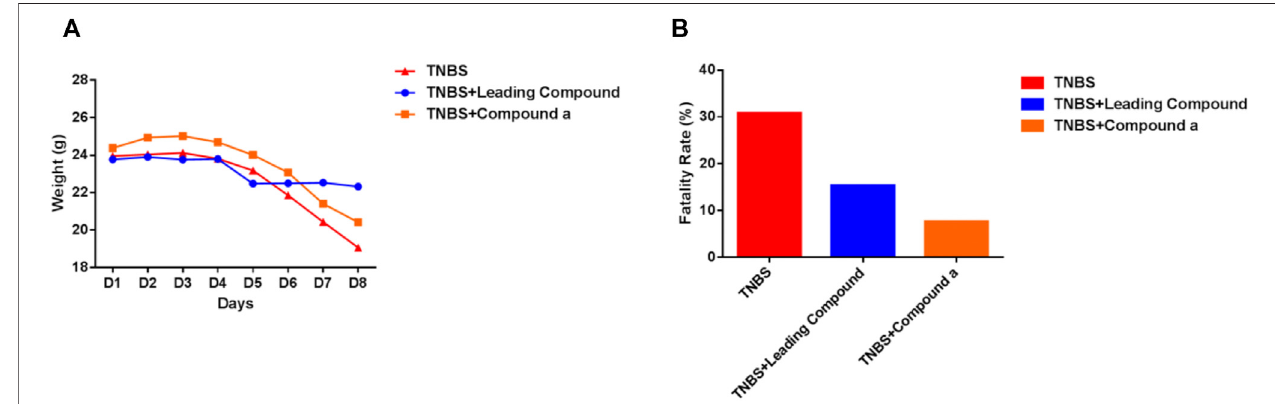
FIGURE8| Clinicalsymptomsofmiceineach group. (A) Changesintheaveragebodyweightofeach groupofmiceduringthemodelingperiod. (B) Fatalityrateof mice in each group ( n (cid:1) 13).